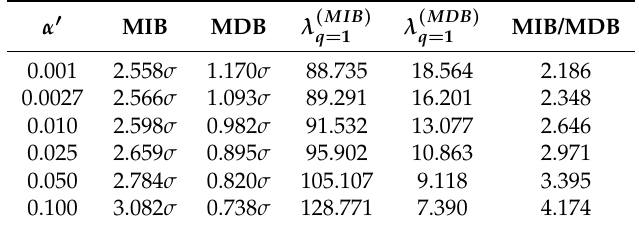
Table 9. Relationship between the MDB and MIB for ∆ h 4 and for ˜ P CD = ˜ P CI = 80%.